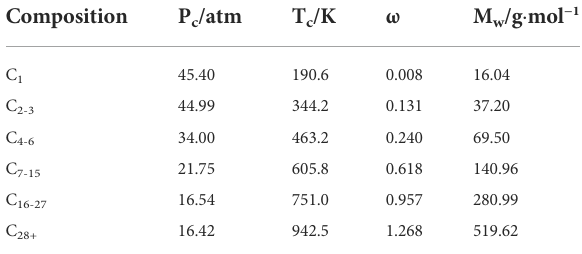
TABLE 4 Physical parameters of components for case 2. TABLE 5 Comparison of calculation results for different models (6599 samples